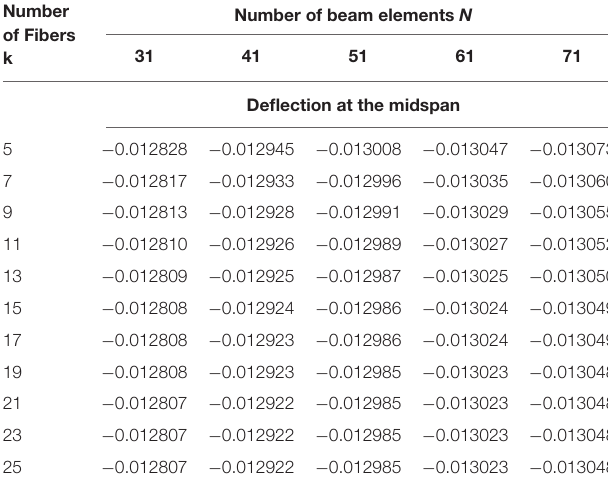
TABLE 1 | Deflection at the midspan in Example